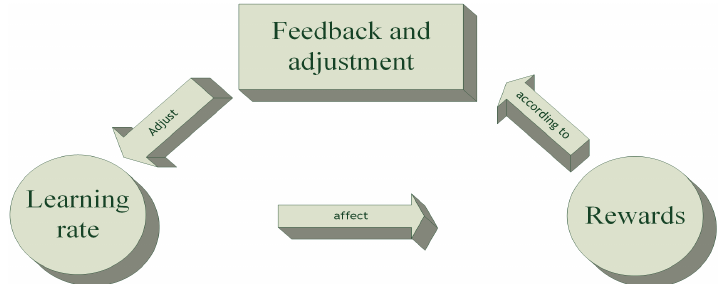
Figure 1. Traditional ways of strengthening learning and adjusting the learning